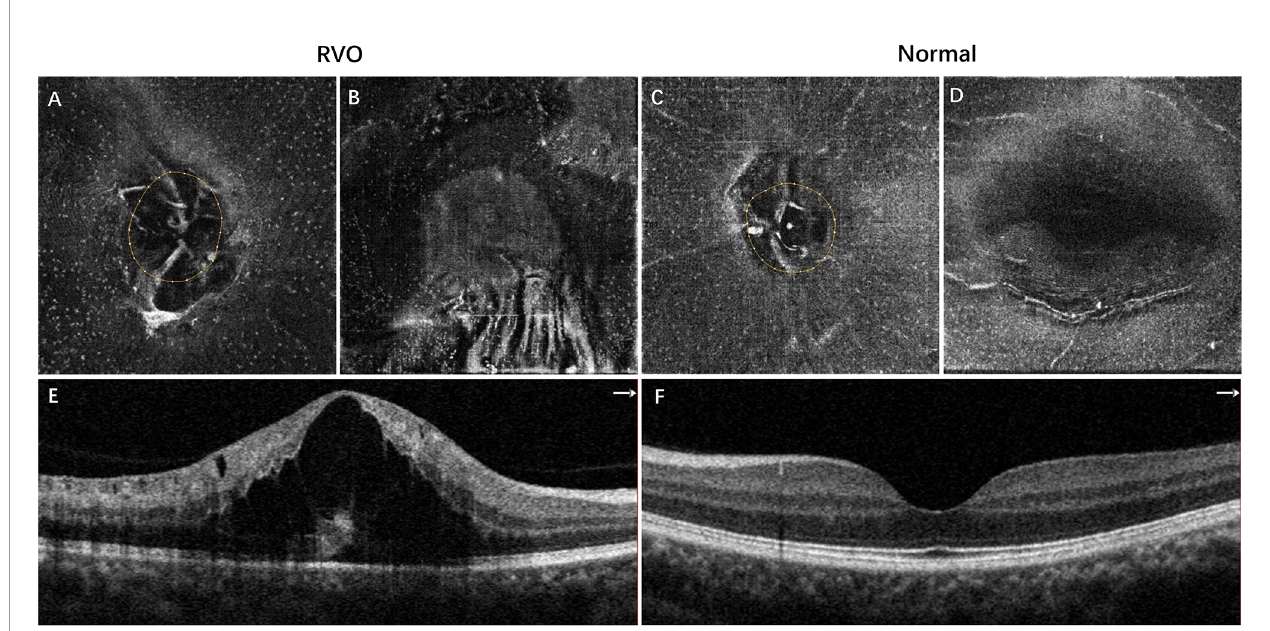
FIGURE 1 | Representative example of inferotemporal BRVO in a right eye (A, B, E) and the normal fellow eye (C, D, F) . (A, C) The 3- m m en face OCT slabs showing MLCs (white dots) in the ONH region. (B, D) The 3- m m en face OCT slabs showing MLCs in the macular region. (E) OCT B scan showing cystoid macular edema of BRVO. (F) Normal OCT B scan of the normal eye. The MLCs were more abundant in both ONH and macular regions in the eye with BRVO. BRVO, branch retinal vein occlusion; OCT, optical coherence tomography; MLCs, macrophage-like cells; ONH, optic nerve